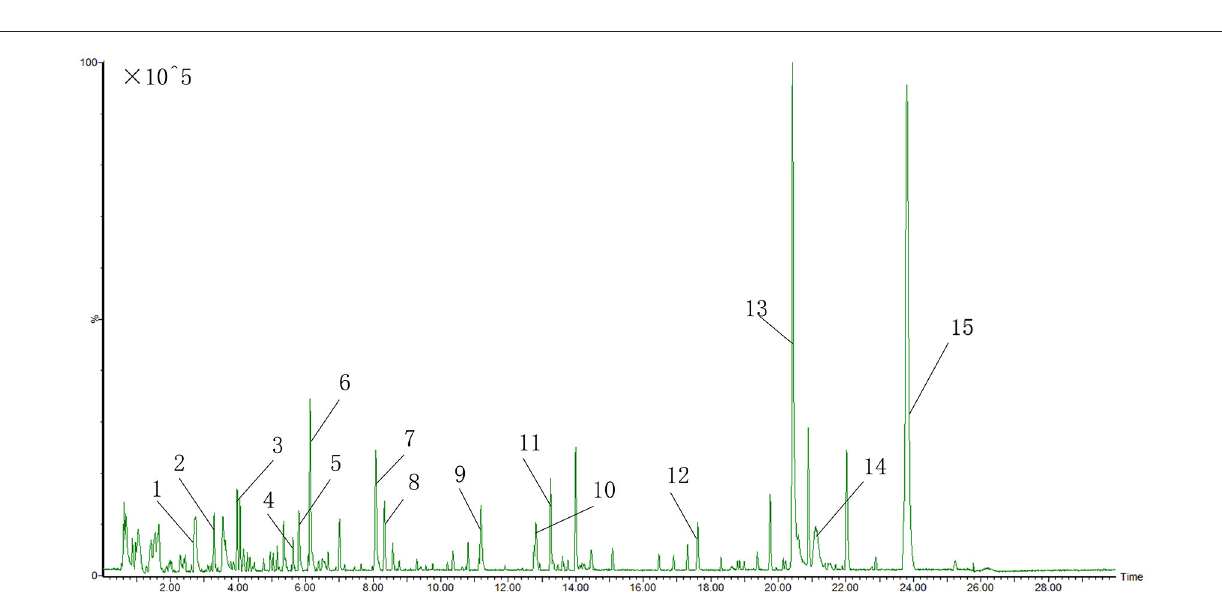
FIGURE 5 | UPLC-QTOF-MS characteristic chromatogram of CHM granules (6 herbs). 1.Albiflorin; 2.Paeoniflorin; 3.Baicalin; 4.Ononin; 5.Tanshinol B; 6.Calycosin; 7.Formononetin; 8. Rhamnocitrin; 9.Dihydrotanshinone I; 10.Cryptotanshinone; 11.Dimethyl Lithospermate; 12.Tanshindiol B; 13.3-Indole Carboxylic Acid Glucuronide; 14.Beta-Carotene; 15.2-Nitrophenyl